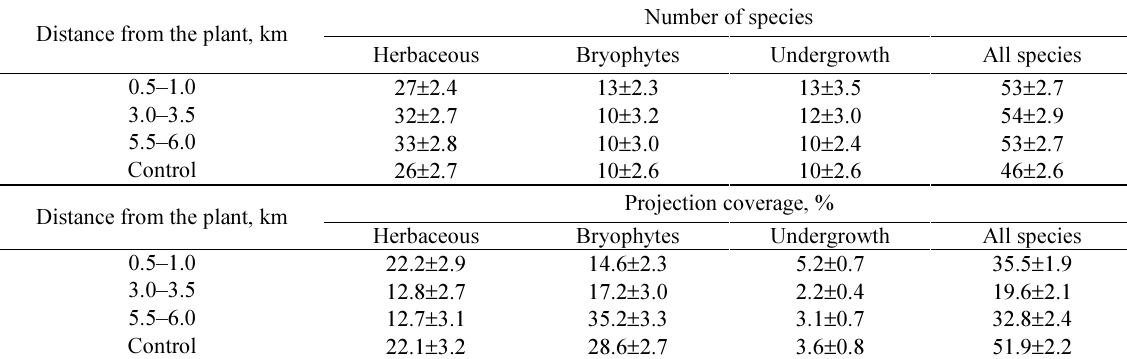
Fig. 5. The average number of herbaceous, bryophyte and undergrowth species at different distances from the pollution source Table 2. Mean abundance and projection coverage of vegetation in vicinity of “Akmenės